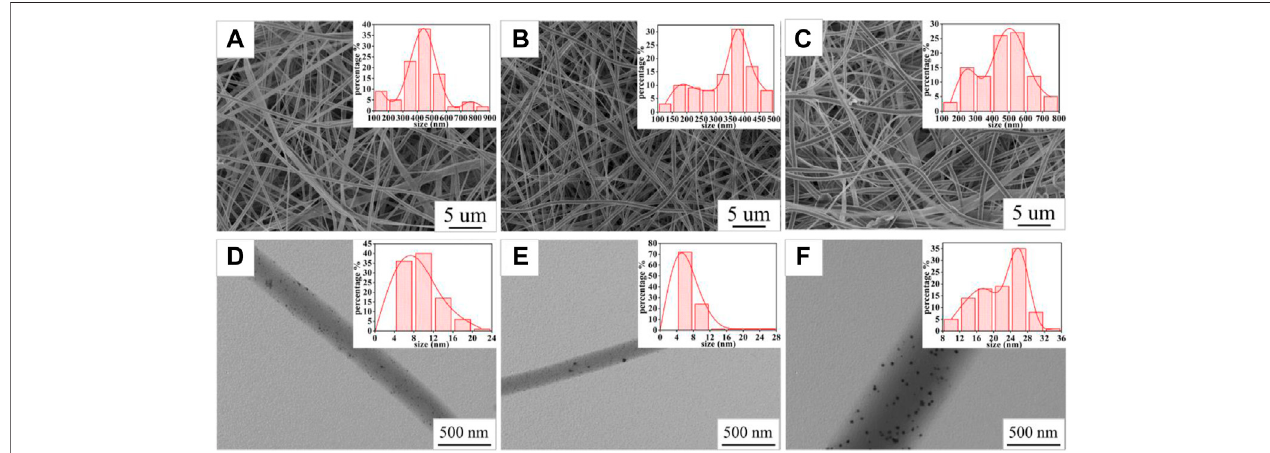
FIGURE 3 | SEM images of SF2 (A) , SF1 (B) , and SF3 (C) ; TEM images of SF2 (D) , SF1 (E) , and SF3 (F) ; the insets in (A,B,C) are the fi ber diameter distribution graphs of SF2, SF1, and SF3; the insets in (D,E,F) are the Ag NP size distribution graphs of SF2, SF1, and SF3.